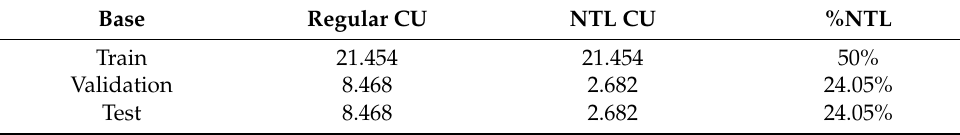
Table 10. Training, validation and testing DB.